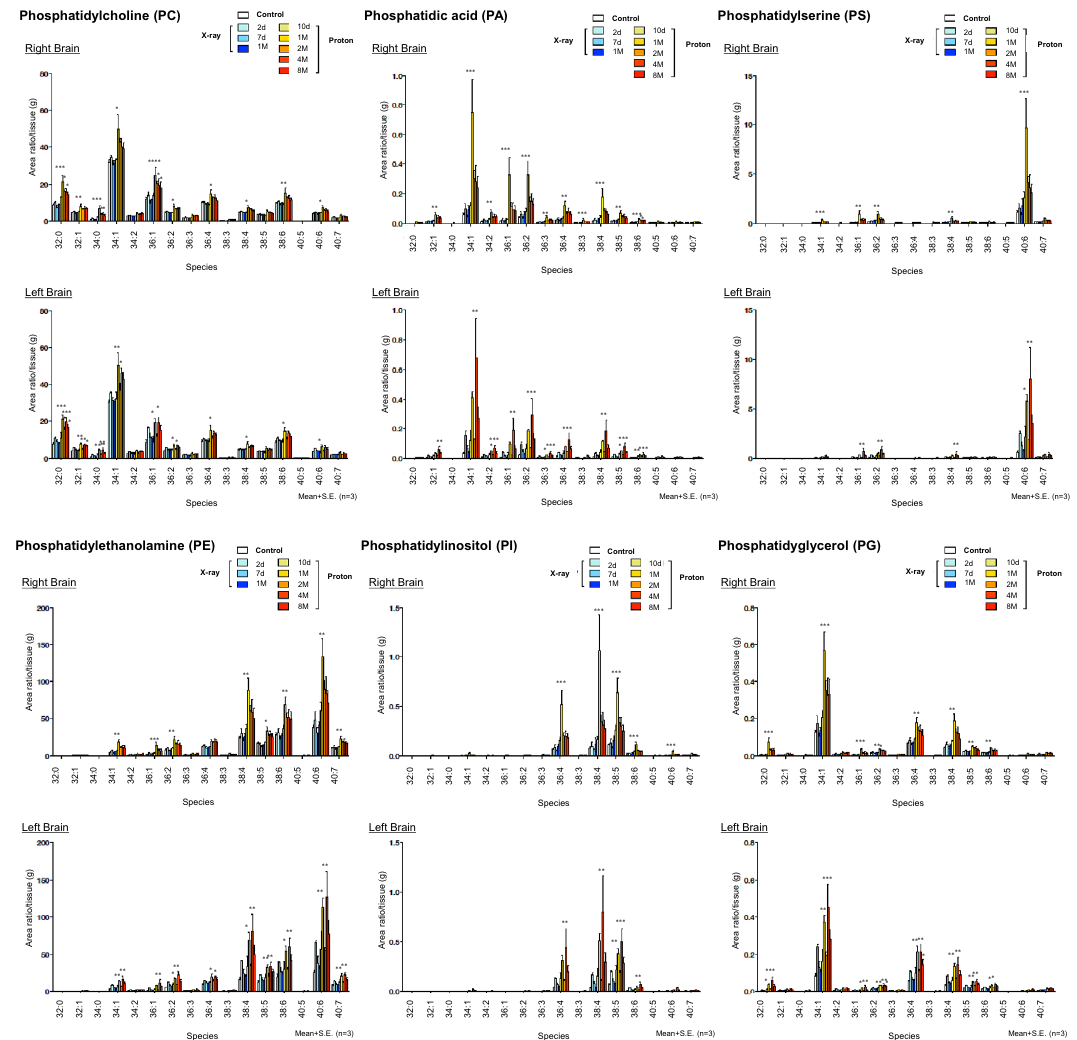
Figure 1. Phospholipid changes after irradiation in the brain radiation necrosis (RN) model as detected by LC– MS/MS. Quantitative changes of phosphatidylcholine (PC), phosphatidyl acid (PA), phosphatidylserine (PS), phosphatidylethanolamine (PE), phosphatidylinositol (PI) and phosphatidylglycerol (PG) of the right or left hemisphere of control or irradiated mice at 10 days, 1 month, 2 months, 4 months, and 8 months after proton beam irradiation, or at 2 days, 7 days, and 1 month after X-ray irradiation ( n = 3 per group). Upper graphs indicate the right hemisphere and lower graphs indicate the left hemisphere. S. E. standard error. * P < 0.05, ** P < 0.01, *** P < 0.001, **** P < 0.0001 versus non-irradiated control mice; one-way analysis of